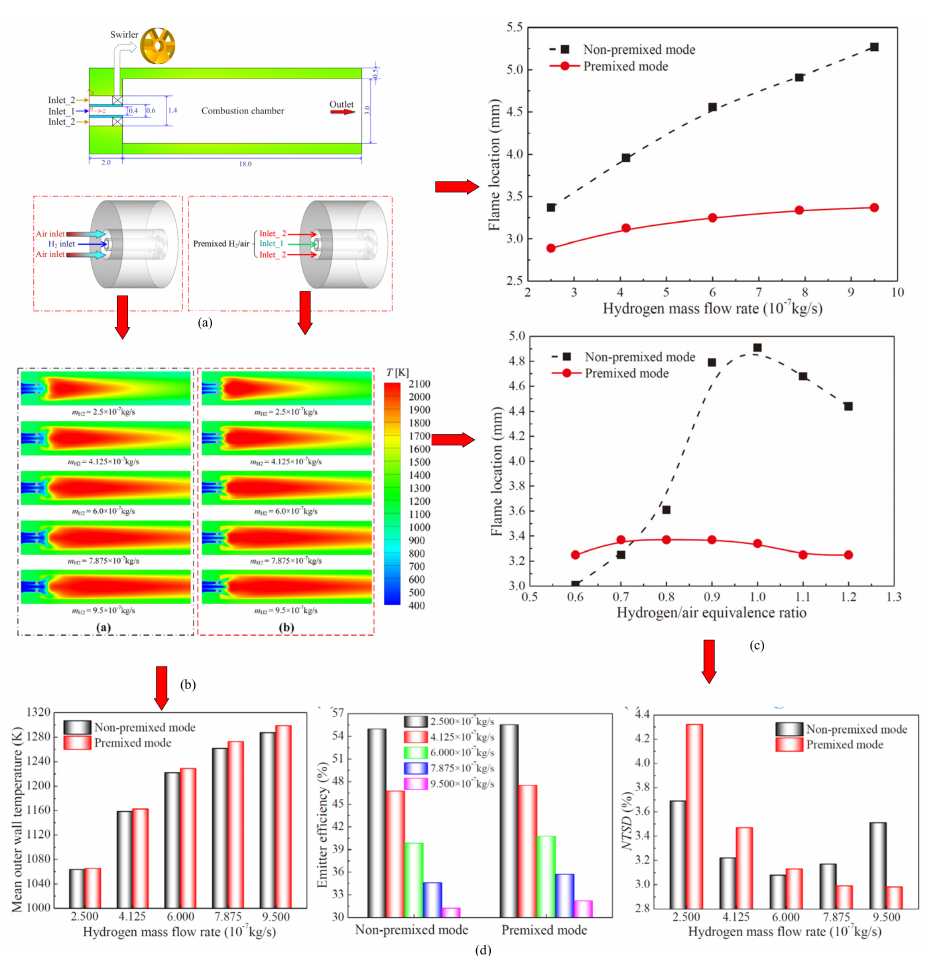
Figure 5. Combustion and performance characteristics of the microscale combustor. ( a ) Swirling